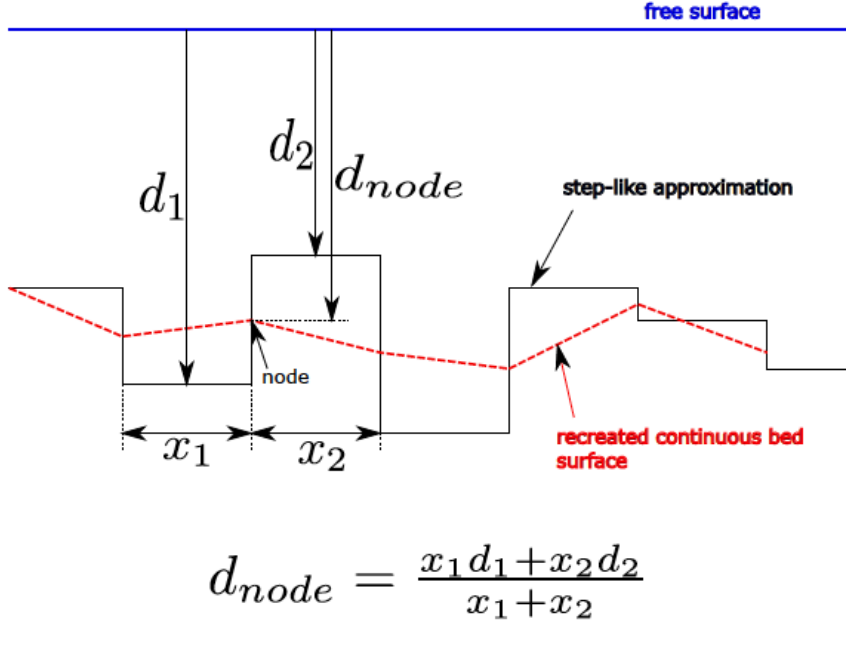
Figure 3. Reconstructing the bed geometry: the 2D case. The red dotted line is the reconstructed continuous